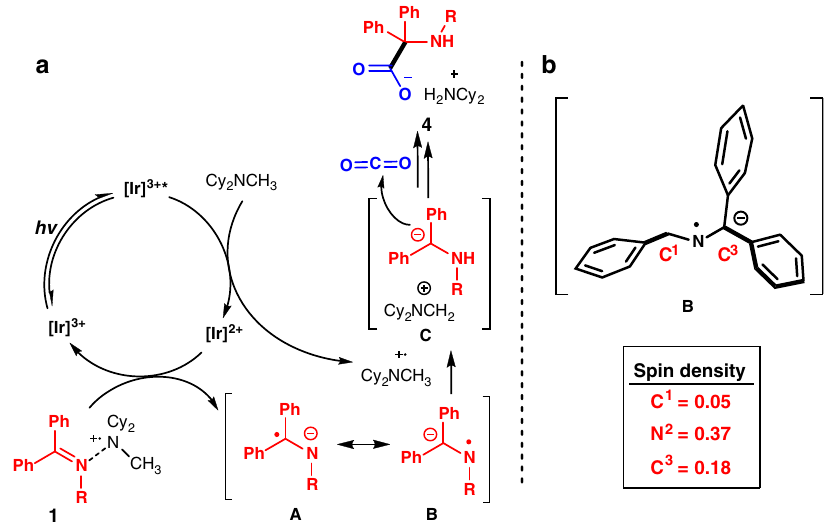
Fig. 7 Reaction pathway. a Plausible mechanism. b Computational spin density of the radical anion